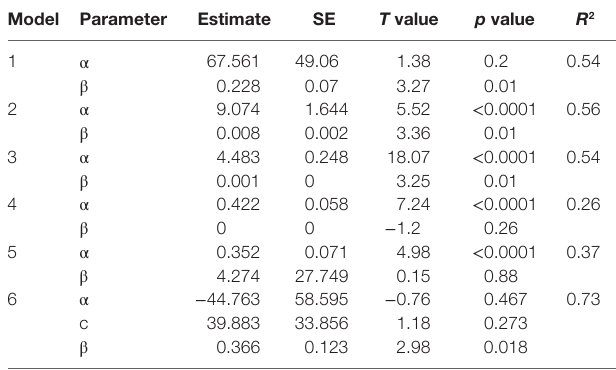
TABLe 2 | Parameter estimation and model